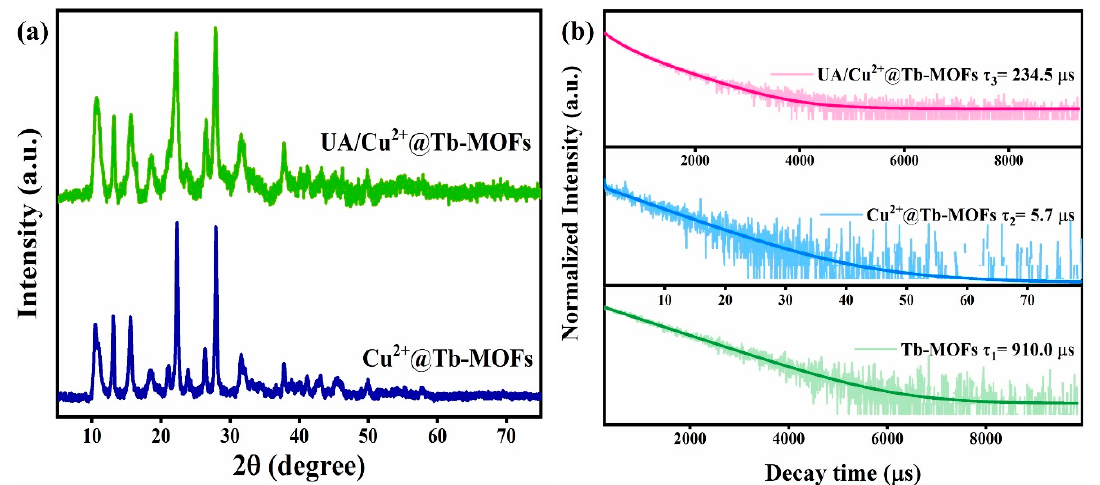
Figure 3. ( a ) PXRD pattern of Cu 2+ @Tb-MOFs and UA/Cu 2+ @Tb-MOFs; ( b ) Luminescence decay curve of Tb-MOFs, Cu 2+ @Tb-MOFs and UA/Cu 2+ @Tb-MOFs at 545 nm. The XPS patterns of Tb-MOFs, Cu 2+ @Tb-MOFs and UA/Cu 2+ @Tb-MOFs are shown in Figure 4. After the introduction of UA, the peak position of Cu 2p of UA/Cu 2+ @Tb-MOFs exhibits a higher binding energy (932.5 and 952.5 eV) compared to that of Cu 2+ @Tb-MOFs (932.0 and 952.0 eV) (Figure 4b,c), which is also direct proof of the interaction between Cu 2+ and UA in Cu 2+ @Tb-MOFs [34]; whereas, a new peak position of N 1s (Figure 4d) appeared in the XPS sub-peak of UA/Cu 2+ @Tb-MOFs. Considering N element does not exist in Cu 2+ @Tb-MOFs structure, the signal of N 1s of UA/Cu 2+ @Tb-MOFs could be caused by the addition of uric acid (Figure S8), giving another powerful proof of successful coordination. Therefore, it can be speculated that, after the addition of uric acid recognition, Cu 2+ reacts with uric acid in the UA/Cu 2+ @Tb-MOFs system fixed on the surface or in the holes of